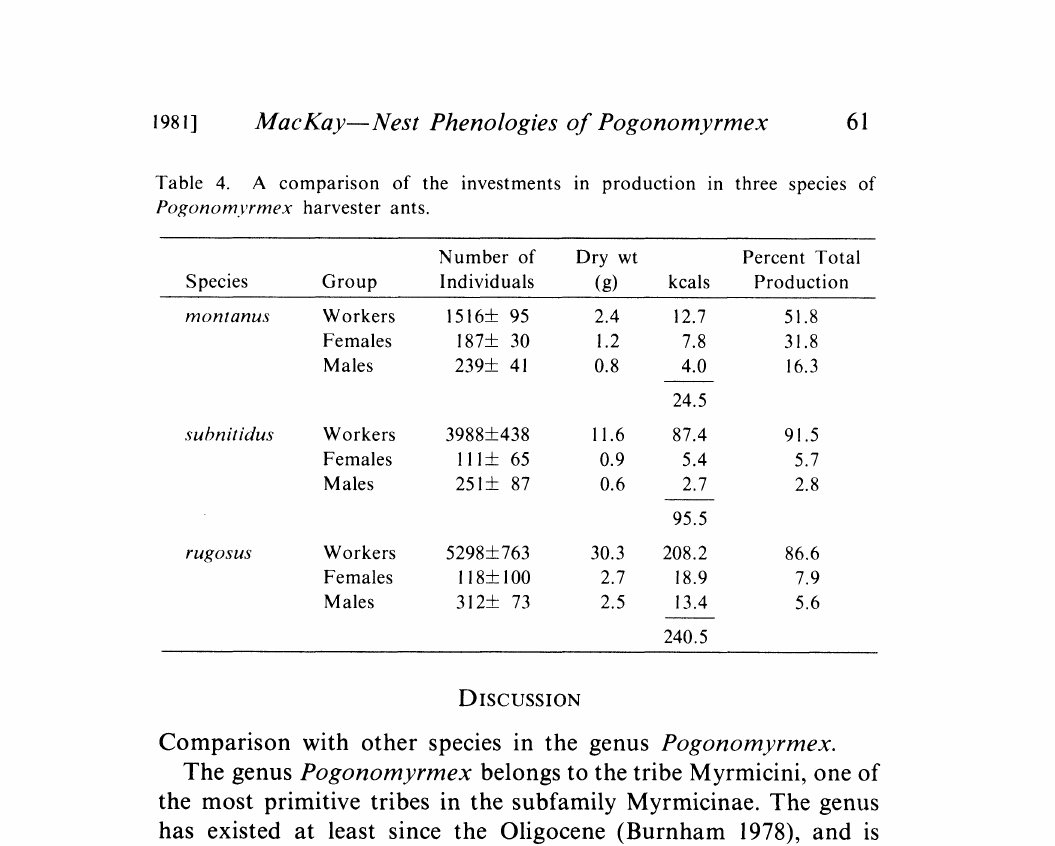
Table 4. A comparison of the investments in production in three species of Pogonomyrmex harvester ants. Number of Dry